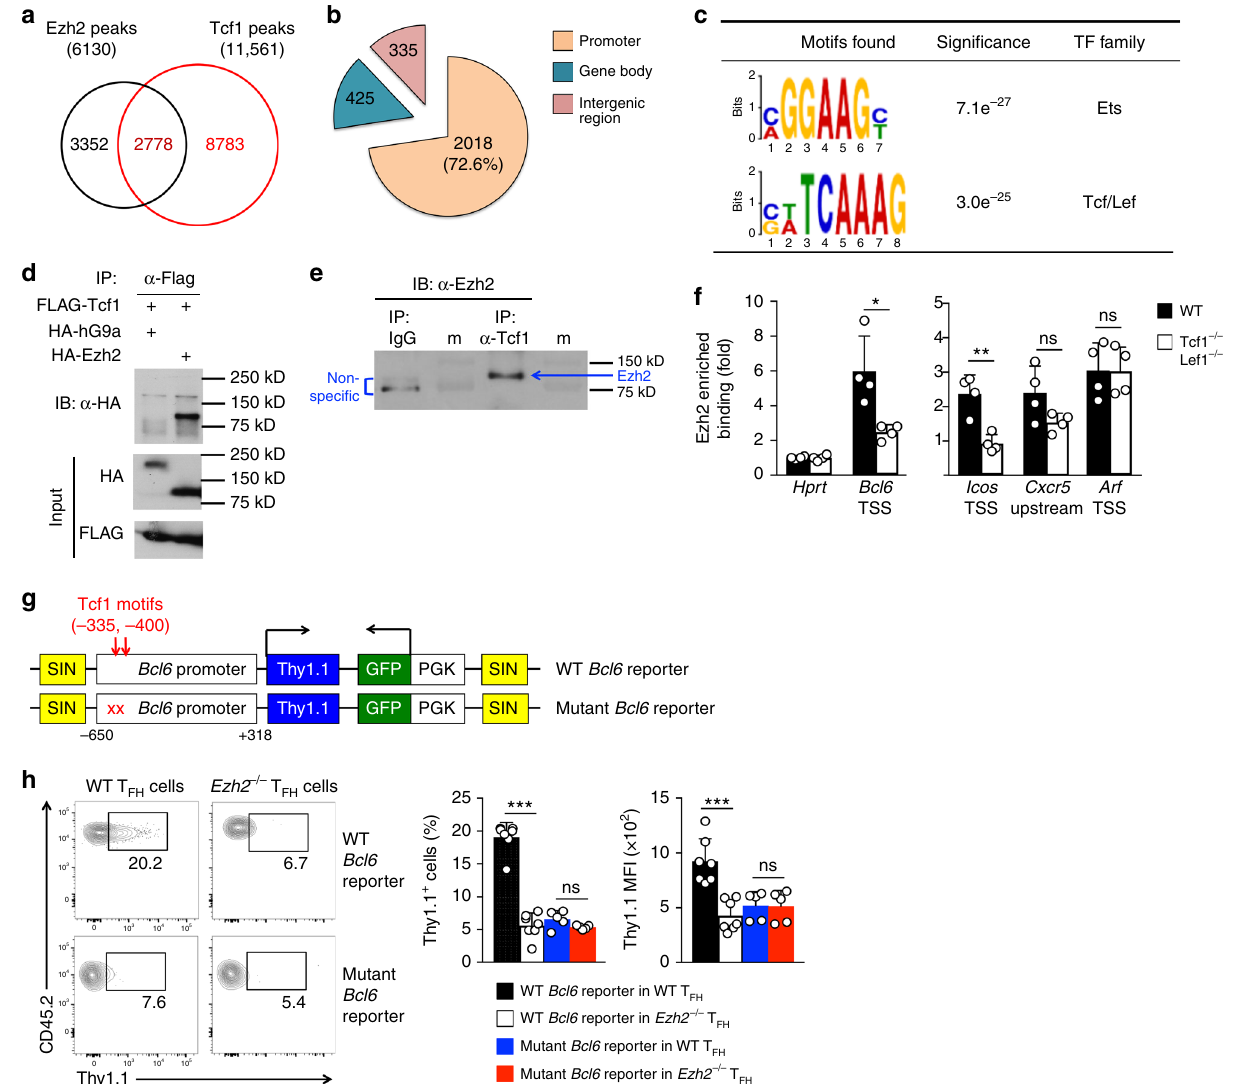
Fig. 4 Ezh2 cooperates with Tcf1 to activate key T FH genes. a Venn diagram showing overlap between Ezh2 and Tcf1 binding peaks in T FH cells. b Distribution of Ezh2/Tcf1 co-occupied sites. Promoter is de fi ned as + / – 1 kb region fl anking TSSs, and gene body refers to region covering + 1 kb to transcription end site, with remainder as intergenic region. c De novo motif analysis of Ezh2/Tcf1 co-occupied sites. The motif logos and statistical signi fi cance are listed. d Ezh2, but not G9a, co-immunoprecipitates with Tcf1. FLAG-tagged Tcf1 was co-transfected with HA-tagged Ezh2 or G9a into 293T cells. The cell lysates were immunoprecipitated with anti-FLAG and immunoblotted with anti-HA. Data are representative of two experiments. e Ezh2 co-immunoprecipitates with Tcf1 in primary T FH cells. CXCR5 + SLAM lo T FH cells were sorted from WT mice infected with LCMV-Arm and immunoprecipitated with normal rabbit IgG or anti-Tcf1 followed by immunoblotting with anti-Ezh2. ‘ m ’ denotes marker lane. Data are representative